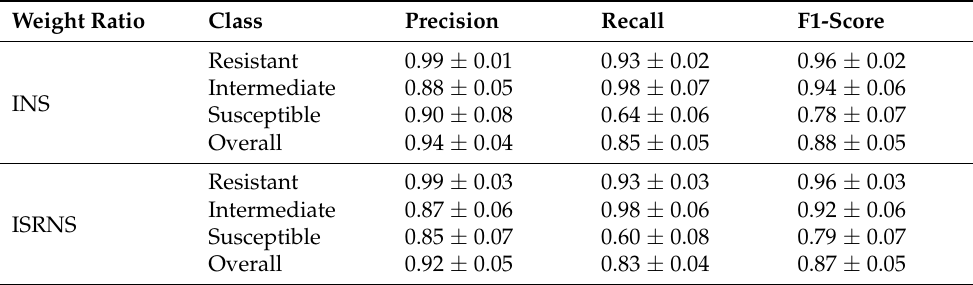
Table 6. Performance (Mean ± SD) during testing using DeepARRNet model trained with the original pea root applying class weighing methods, INS and ISRNS. Weight Ratio Class Precision Recall